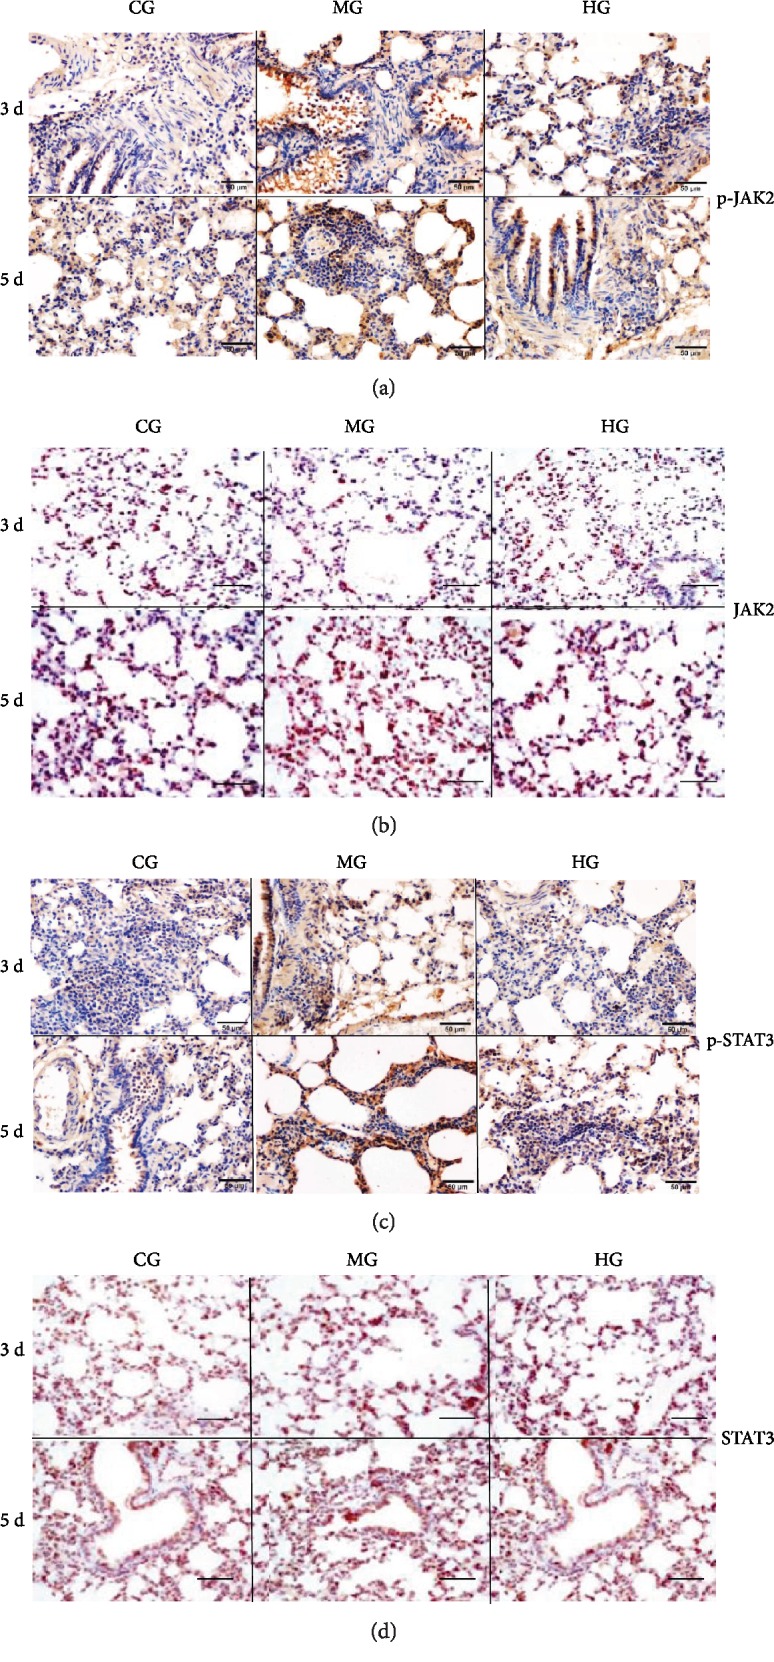
Immunohistochemical analysis of the effects of hydrostatin-SN10 on the relative protein levels of JAK2/STAT3 signaling. (a) p-Jak2. (b) JAK2. (c) p-STAT3. (d) STAT3. n = 12 for each group, and statistical difference was significant if p < 0.05.